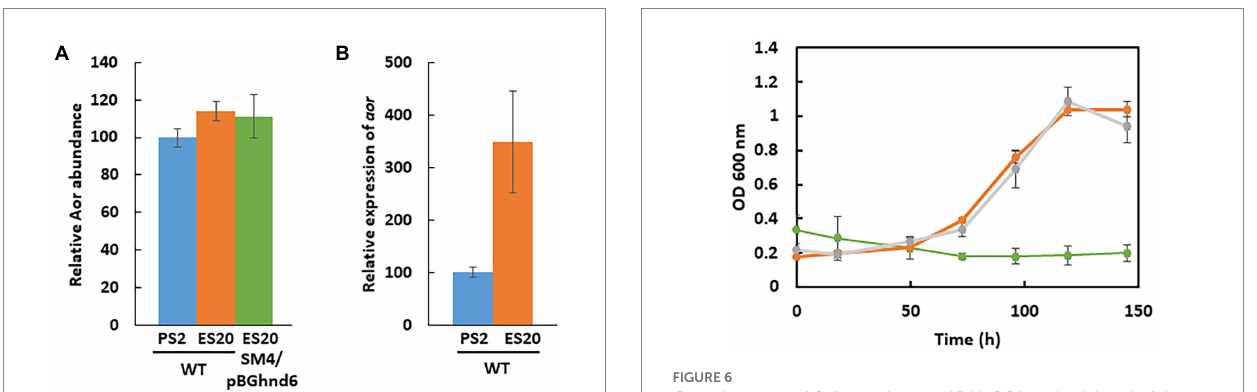
FIGURE 6 Growth curves of S. fructosivorans ADH-CG1 strain deleted of the Adh3929 encoding gene. Bacteria were grown in 100 mL serum bottles containing 90 mL of PS2 (orange curve), PS20 (gray curve) and ES20 (green curve) media. Data represent the averages of the results of three replicate growths. Error bars correspond to standard